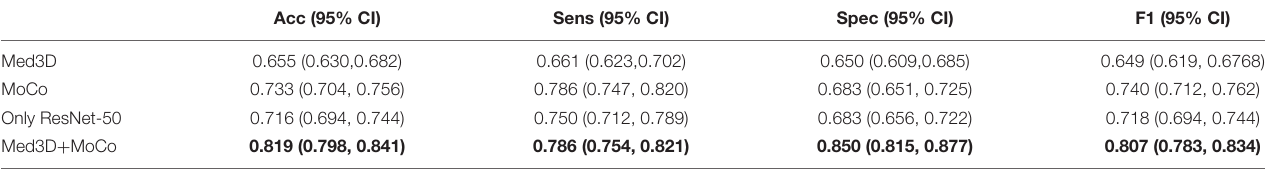
TABLE 3 | Performance of different transfer learning strategies using ResNet-50.